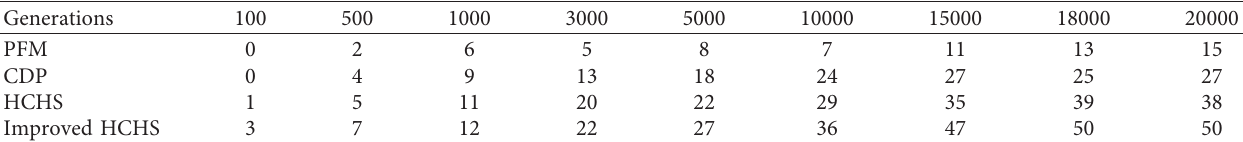
Table 4: Average feasible solutions using different constraint handling methods during the evolutionary process.